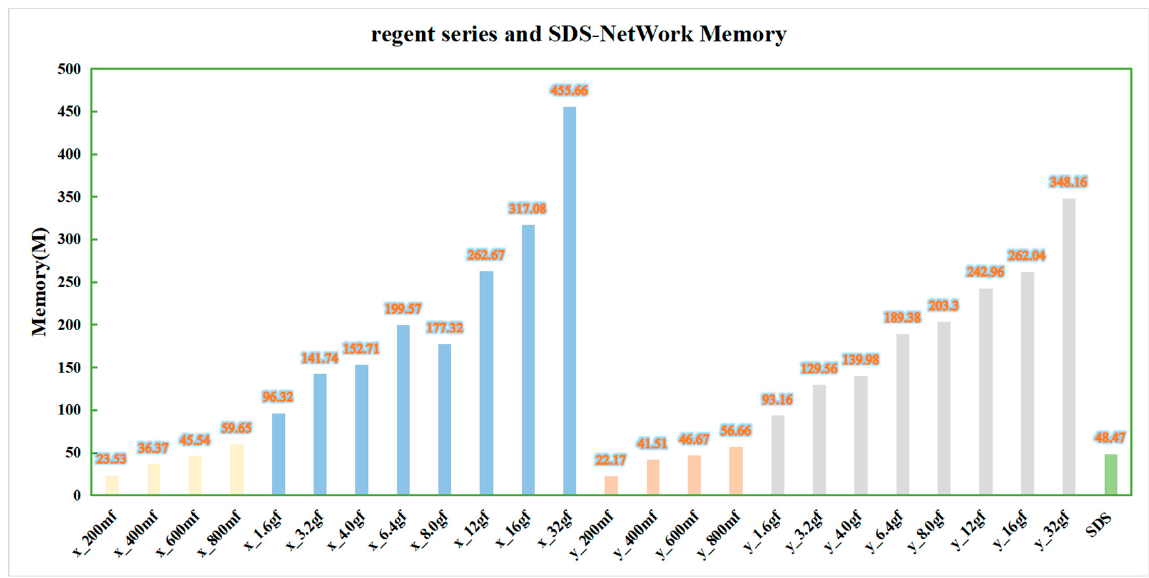
Figure 10. Memory comparison diagram of SDS-Network and regnet algorithm.